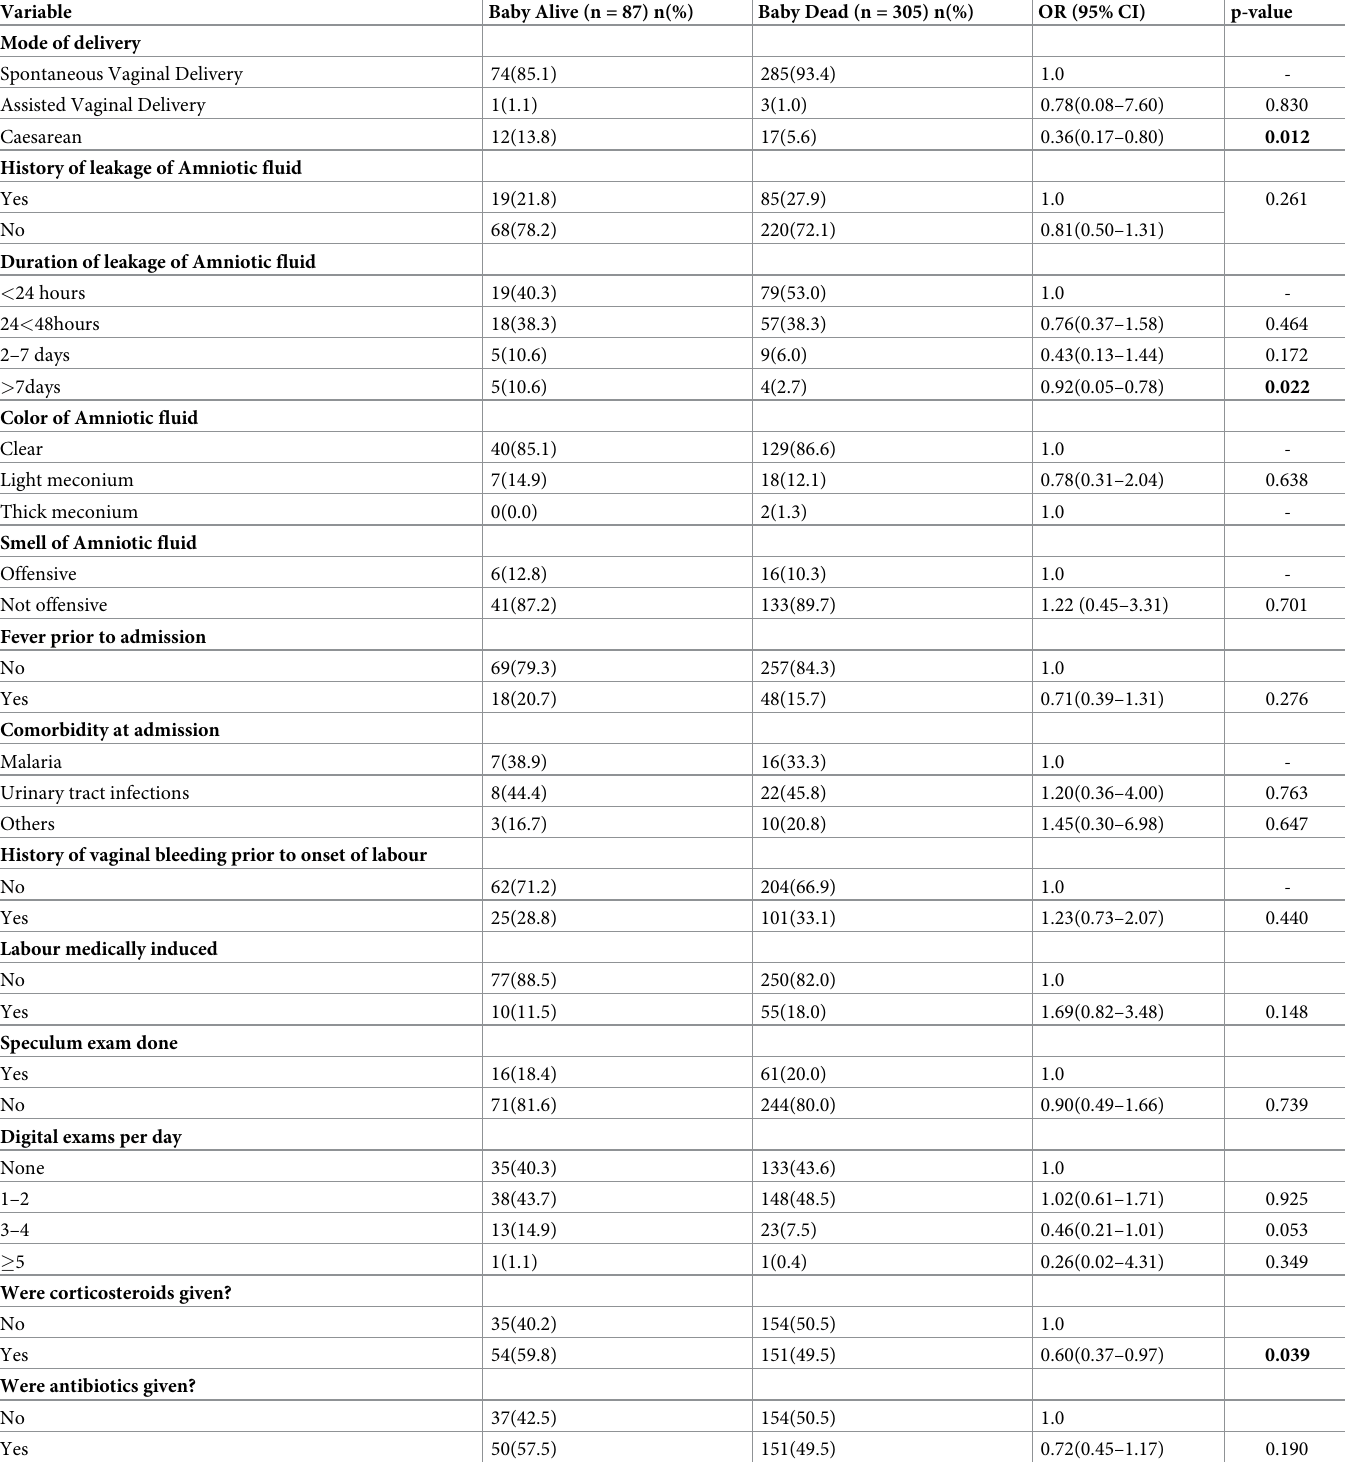
Table 3. Comparison of obstetric characteristics and perinatal mortality among 392 women who had preterm delivery between 24 to 28 weeks of gestation at Kawempe National Referral Hospital, Kampala,